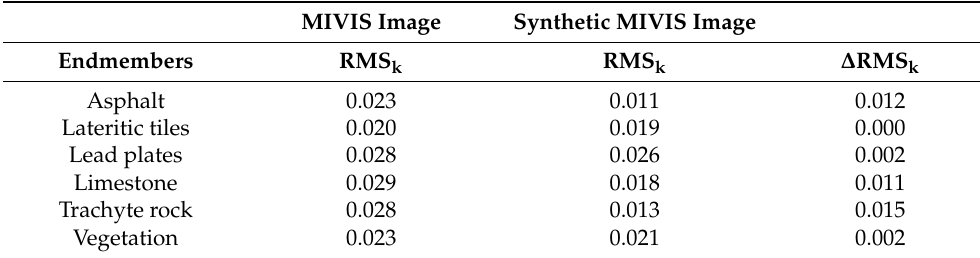
Table 4. In the first and third methods, spectral accuracy estimated with RMS k values that were retrieved from true and synthetic images of MIVIS and the absolute differences between the RMS k values obtained from true and synthetic image ( Δ RMS k ).